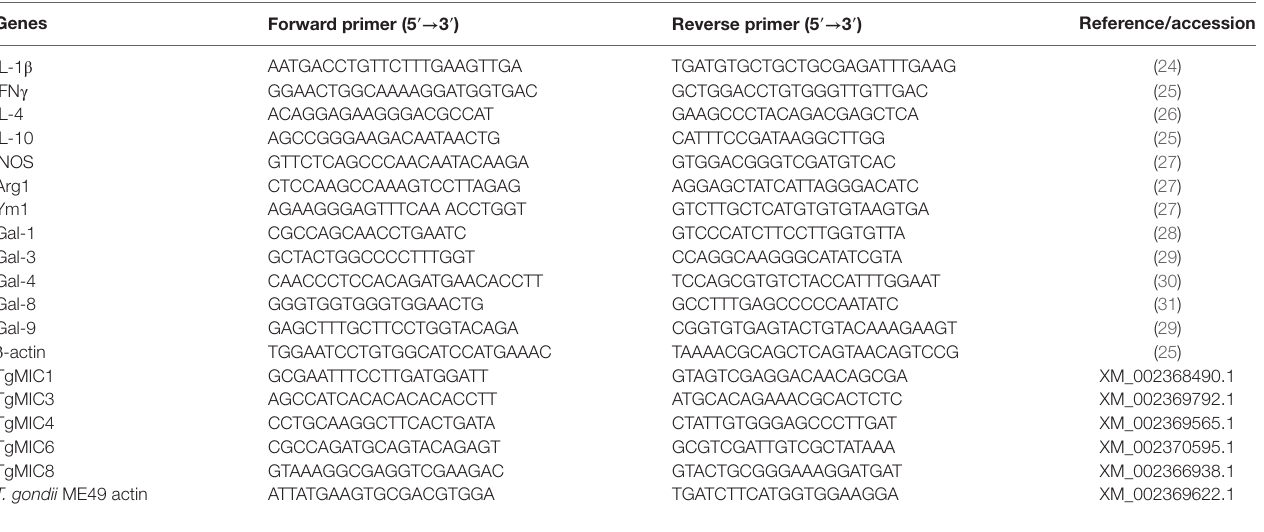
genes Forward primer (5 ′→ 3 ′